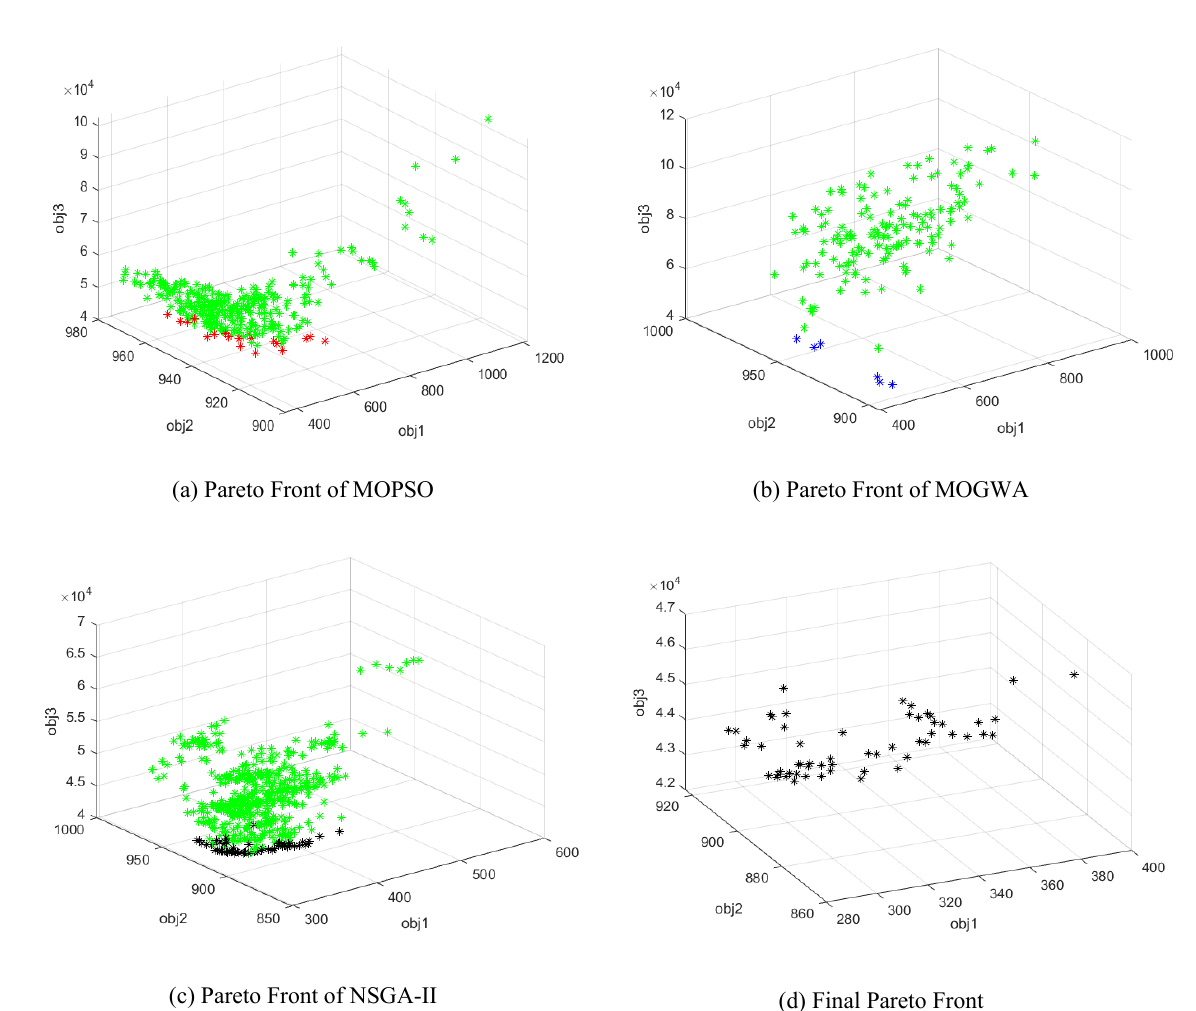
Fig. 9. Pareto Front in the third